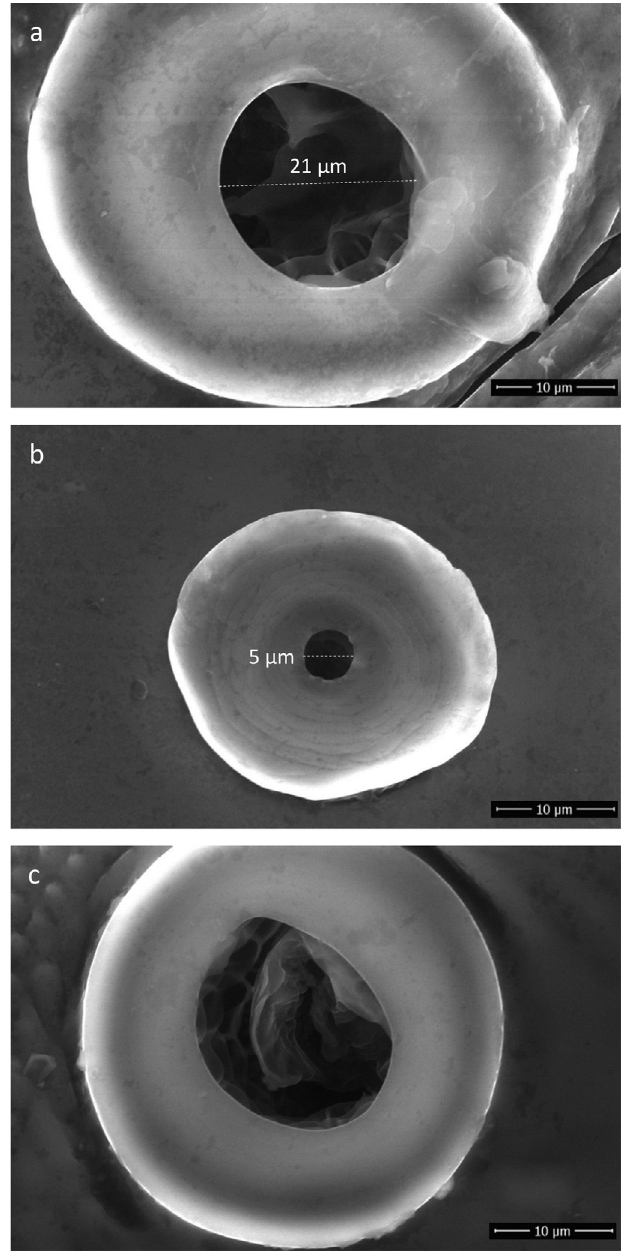
Figure 3. Representative scanning electron micrographs show- ing morphology of head lice spiracles after 24 h water immersion: a) Thoracic spiracle, b) Abdominal spiracle, c) Thoracic spiracle showing secreted